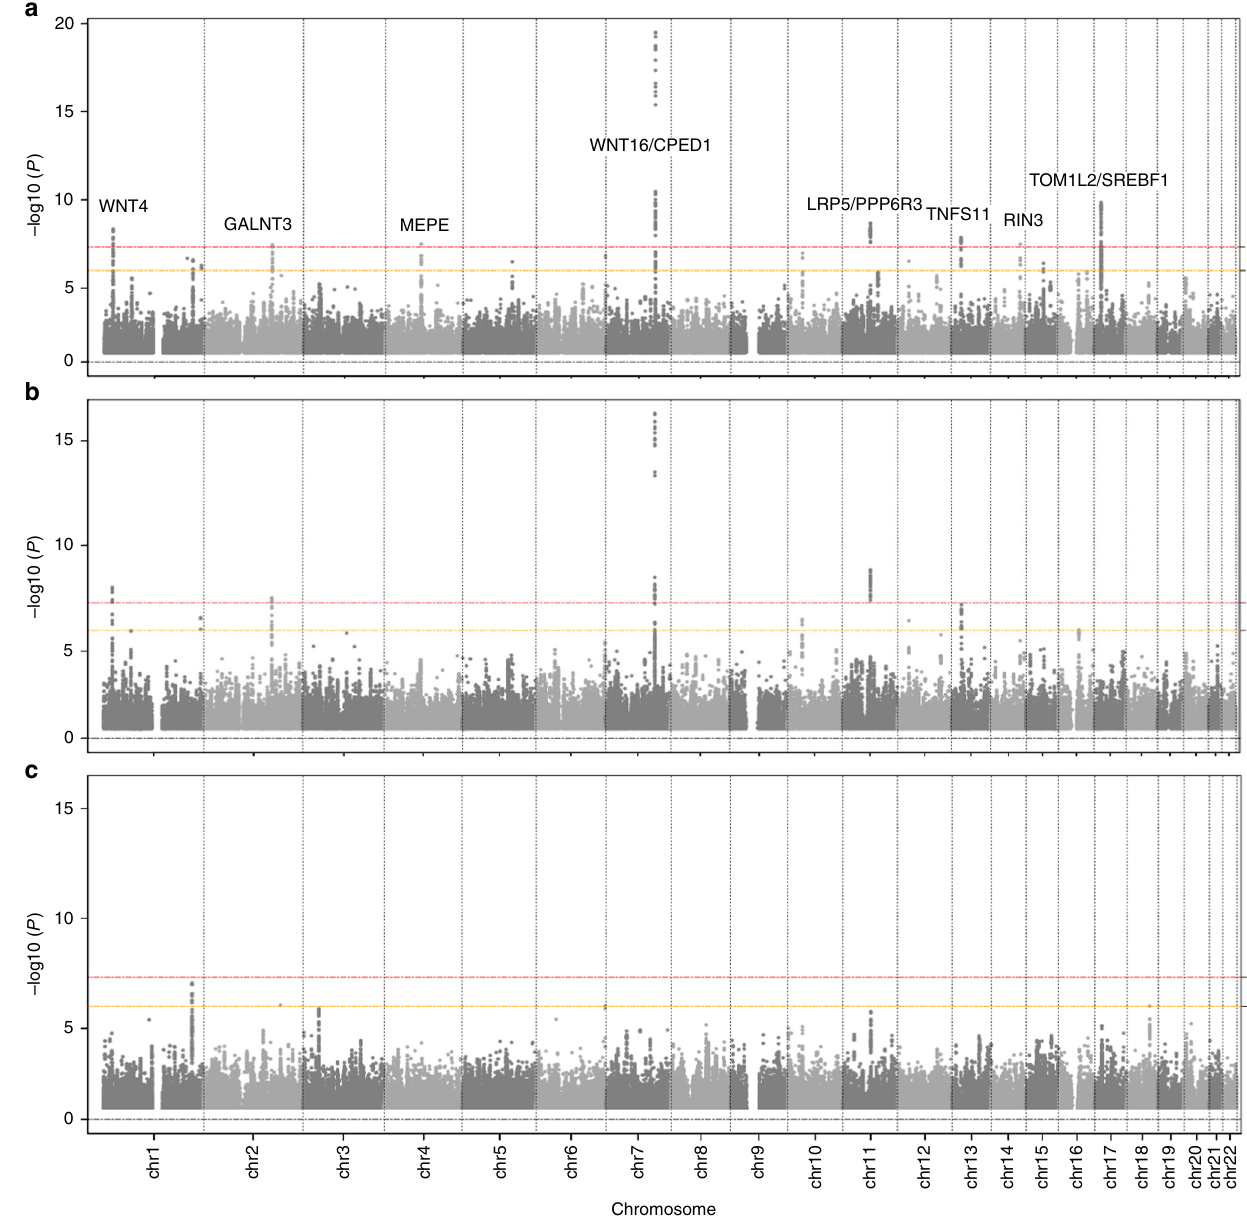
Fig. 1 Manhattan plot of the meta-analyses for musculoskeleta traits. a TBLH-BMD and TB-LM bivariate meta-analysis. b TBLH-BMD meta-analysis. c TB-LM meta-analysis. Dashed red and yellow lines mark the GWS threshold ( P < 5×10 − 8 ) and suggestive threshold ( P < 1×10 − 6 ),